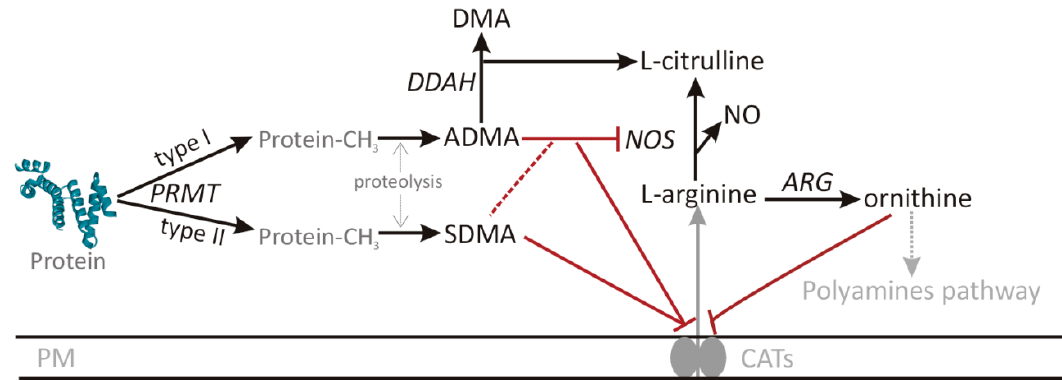
Figure 1. An overview of arginine/nitric oxide pathway. Metabolites are written in a straight script and enzymes in italics. Pathway components not determined in current study are marked in gray. Red color was used for inhibitory effects and a dashed line indicates weak impact. ADMA, asymmetric dimethylarginine; ARG, arginase; CATs, cationic amino acid transporter; DMA, dimethylamine; DDAH, dimethylarginine dimethylaminohydrolase; NOS, nitric oxide synthase; PM, plasma membrane; PRMT, protein methyltransferase.